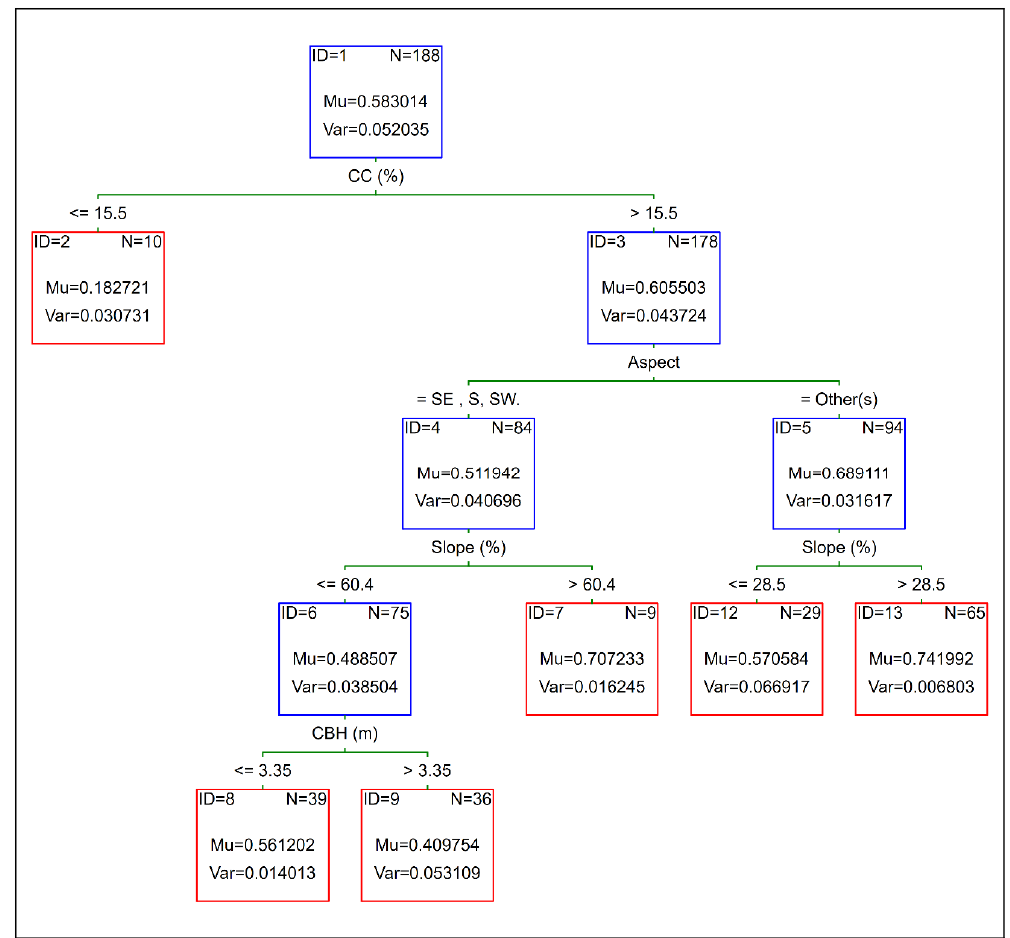
Figure 8. Regression tree for low- and high-density pine forests with FDI as the response variable and topographic and vegetation structural characteristics as independent variable. (N = number of cases in the node ).